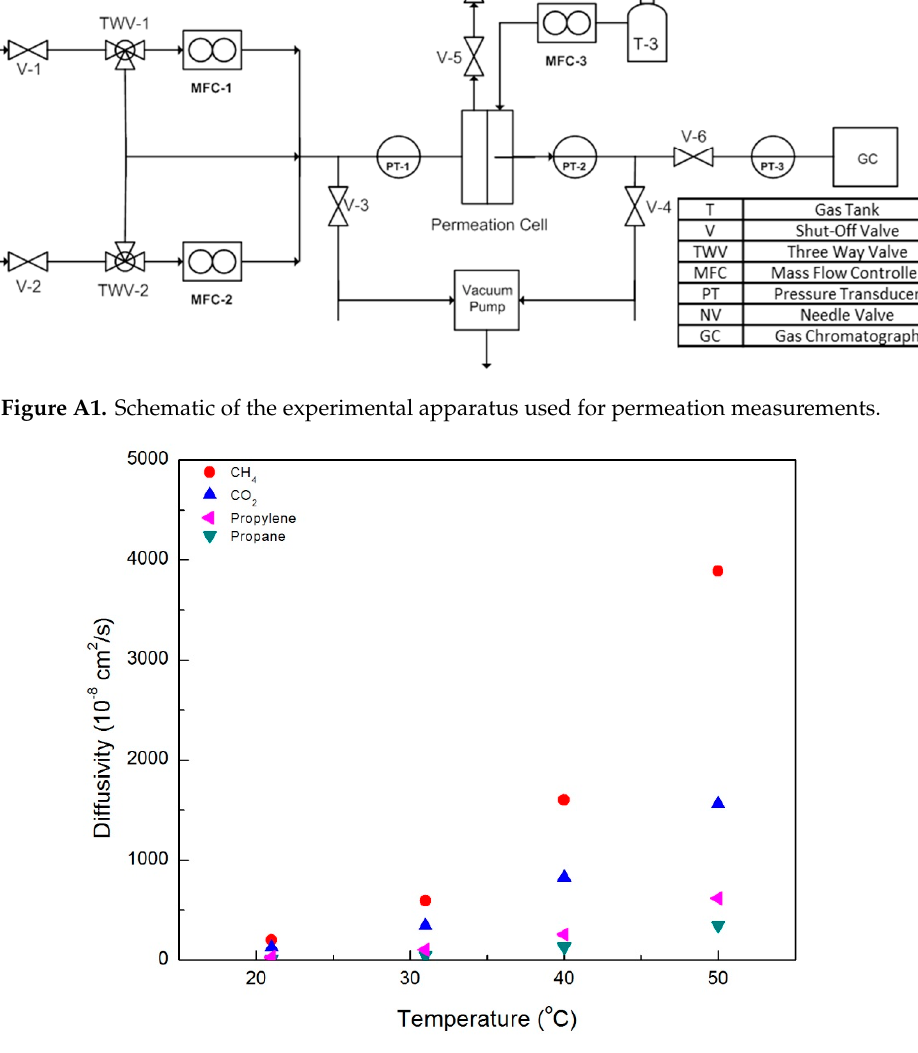
Figure A2. Di ff usivity of various gases in the CNBPh75_2.5 membrane (2.5% crosslinker), plotted as a function of temperature in the nematic phases.